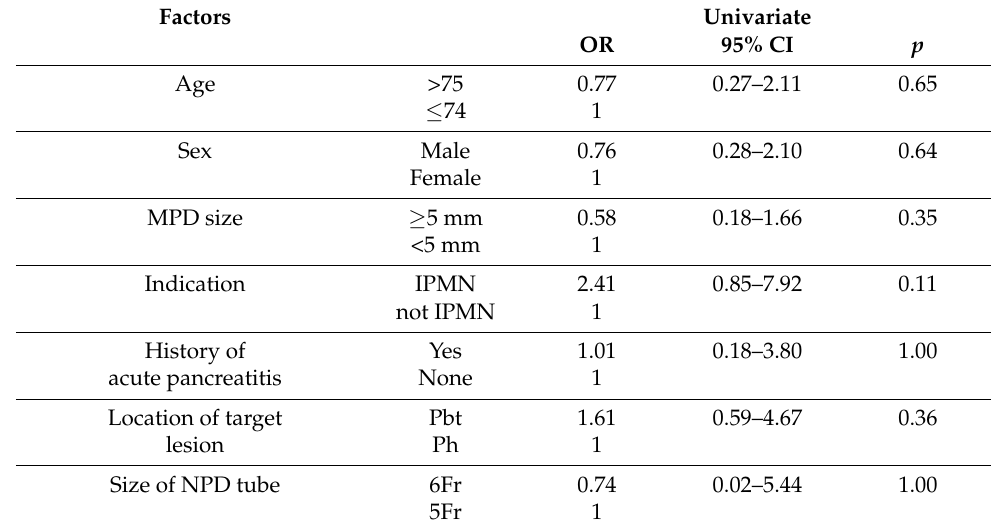
Table 5. Risk factors of PEP in patients who underwent